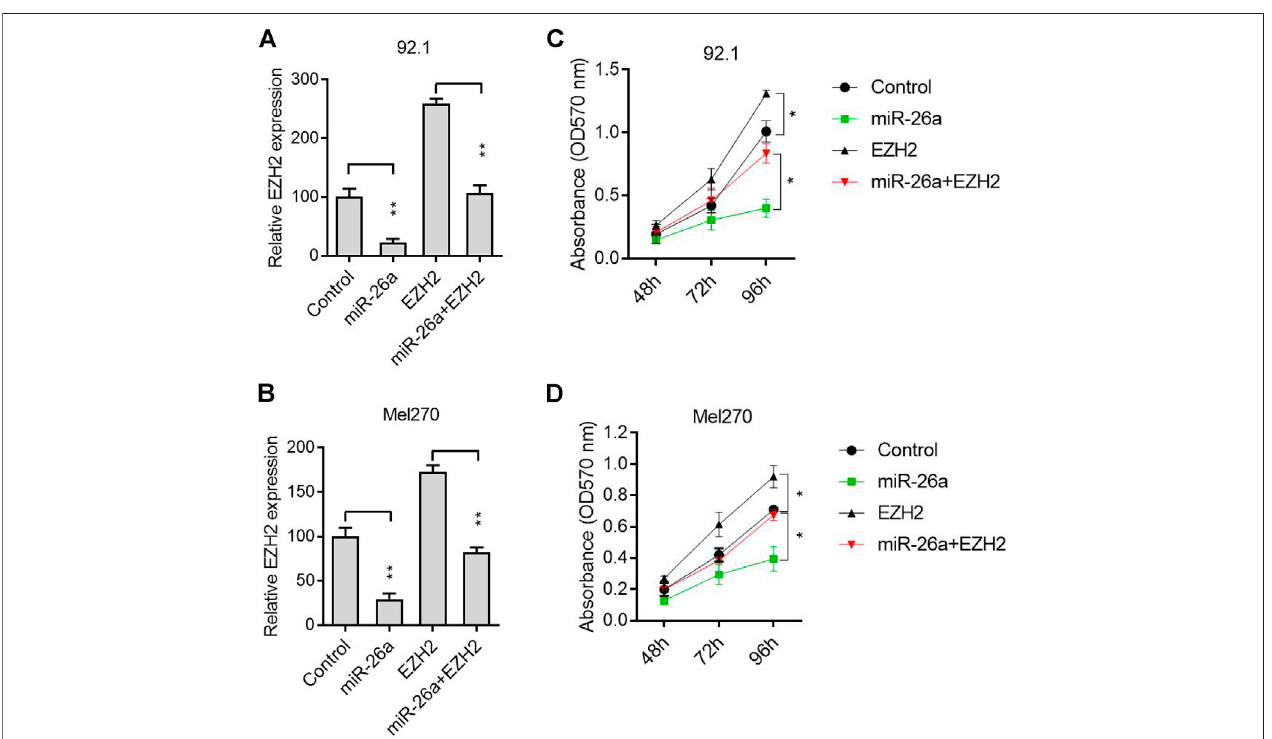
FIGURE3| miR-26asuppressed tumor progressionbytargeting EZH2. (A) Aftertransfection with pcDNA3.1-EZH2 and/or miR-26a mimic inthe 92.1cells, EZH2 expression was evaluated using qRT-PCR (** p < 0.01). (B) qRT-PCR analysis was performed to evaluate EZH2 expression in Mel270 cells (** p < 0.01). (C) MTT assays were performed in 92.1 cells (* p < 0.05). (D) Cell proliferation was assessed in Mel270 cells (* p <